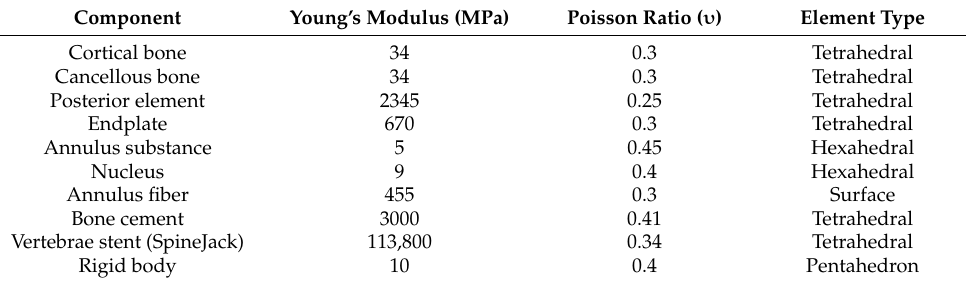
Table 1. Material Properties of the Finite Element Model [18,19].